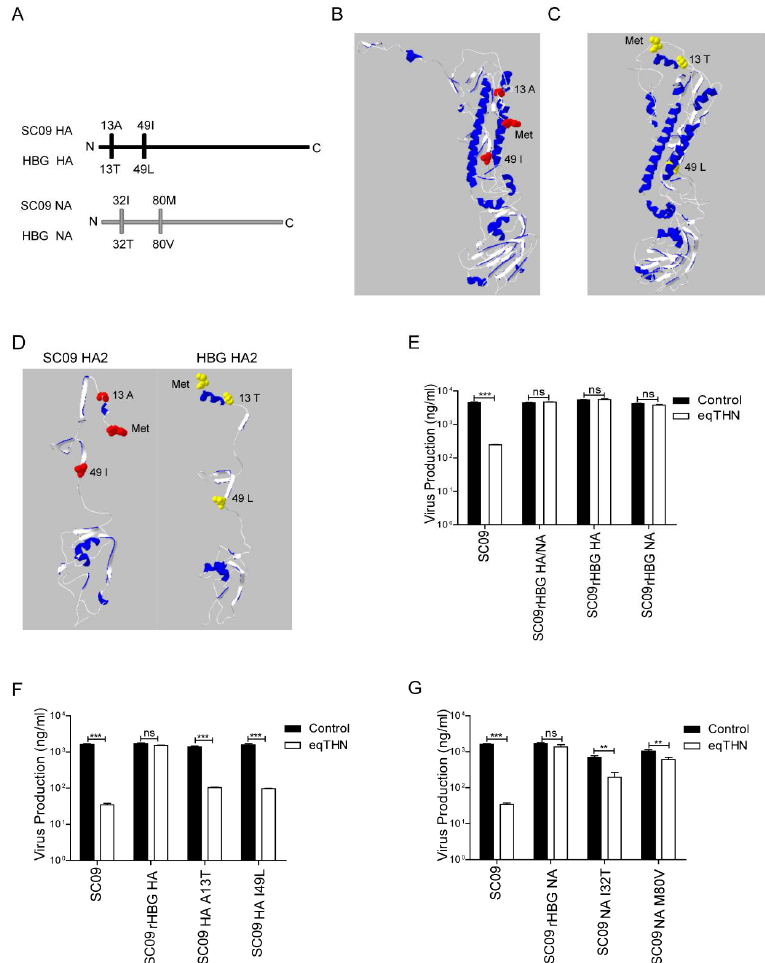
Figure 5. The ability of 13T and 49L in HA, 32T and 80V of NA to facilitate effective release of SC09 from eqTHN-expressing cells. ( A ) Amino acid sequence alignment of NA and HA between SC09 and HBG. Distinct sites were displayed; ( B ) Structure prediction of HA of SC09 using Phyre2. The analysis was performed using Swiss-PBD Viewer software; ( C ) Structure prediction of HA of HBG using Phyre2. The analysis was performed using Swiss-PBD Viewer software; ( D ) Structure prediction of HA2 domain of SC09 and HBG. The analysis was performed using Swiss-PBD Viewer software; ( E ) The amounts of SC09, SC09 rHBG HA/NA , SC09 rHBG HA and SC09 rHBG NA released from MDCK and eqTHN-expressing MDCK cells at 48 h post-infection at an MOI of 0.1. Infection and detection were carried out as described as above. The results of a single experiment performed with triplicate samples are shown, and results were subsequently confirmed in three separate experiments. Error bars indicate standard deviations (SD); ( F ) The amounts of SC09, SC09 rHBG HA , SC09 HA A13T and SC09 HA I49L released from MDCK and eqTHN-expressing MDCK cells at 48 h post-infection at an MOI of 0.1. Infection and detection were carried out as described as above. The results of a single experiment performed with triplicate samples are shown, and results were subsequently confirmed in three separate experiments. Error bars indicate standard deviations (SD); ( G ) The amounts of SC09, SC09 rHBG NA , SC09 NA I32T and SC09 NA M80V released from MDCK and eqTHN-expressing MDCK cells at 48 h post infection at an MOI of 0.1. Infection and detection were carried out as described as above. The results of a single experiment performed with triplicate samples are shown, and results were subsequently confirmed in three separate experiments. Error bars indicate standard deviations